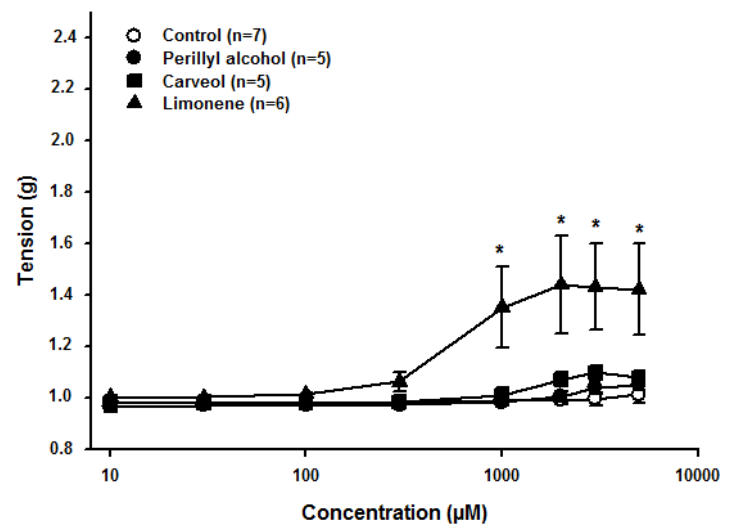
Figure 2. Effects of limonene, carveol, and perillyl alcohol on the resting tonus of rat aortic rings. * indicates statistical difference compared to the control ( p < 0.05, one-way ANOVA and Holm-Sidak test). Each control consisted of the same concentration of vehicle as in the experimental case, but without the experimental substance.